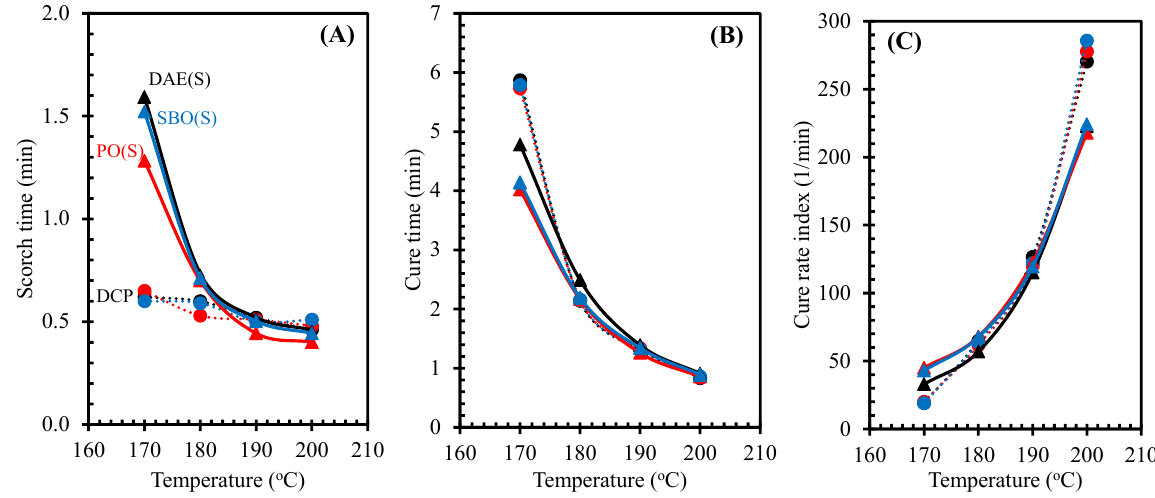
Figure 5. Scorch time ( A ), cure time ( B ), and cure rate index ( C ) of NR compounds containing different types of oils with various curing systems as a function of curing temperatures.